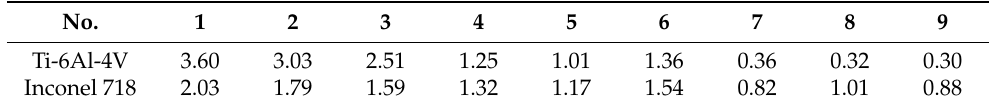
Table 6. Tool life results of the experiments in Step A (km).